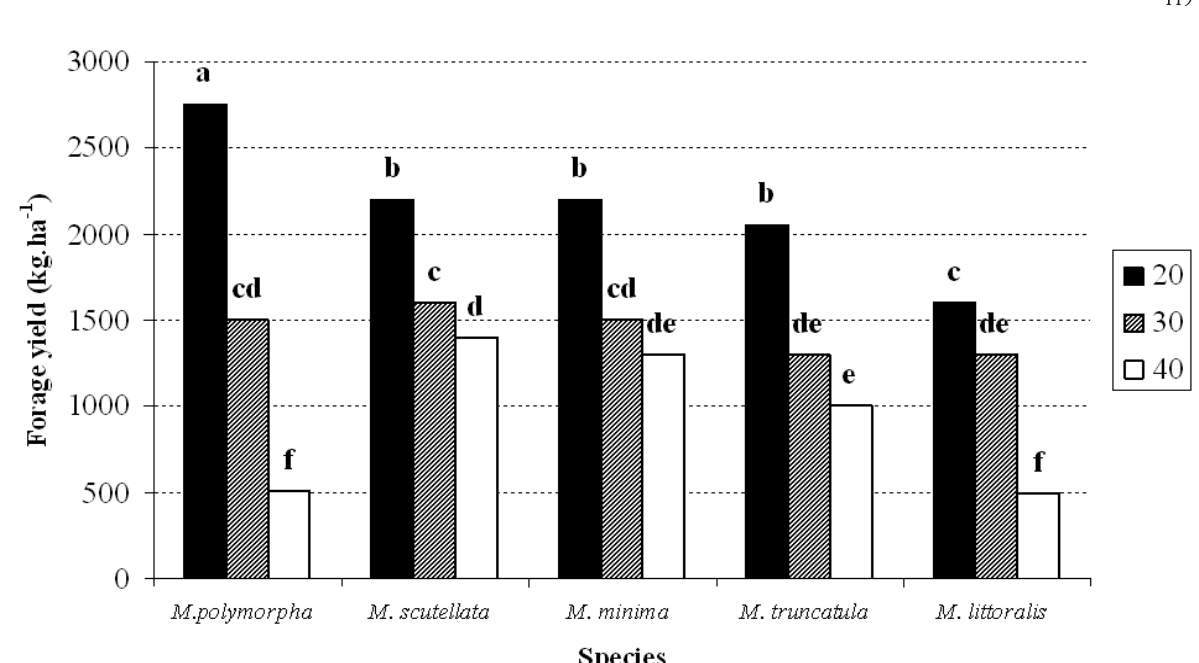
levelFig. 1. Interaction effect between species and within row spacing on forage yield. All the values followed by the same letter in each column are not statistically different at the p<0.05 probability